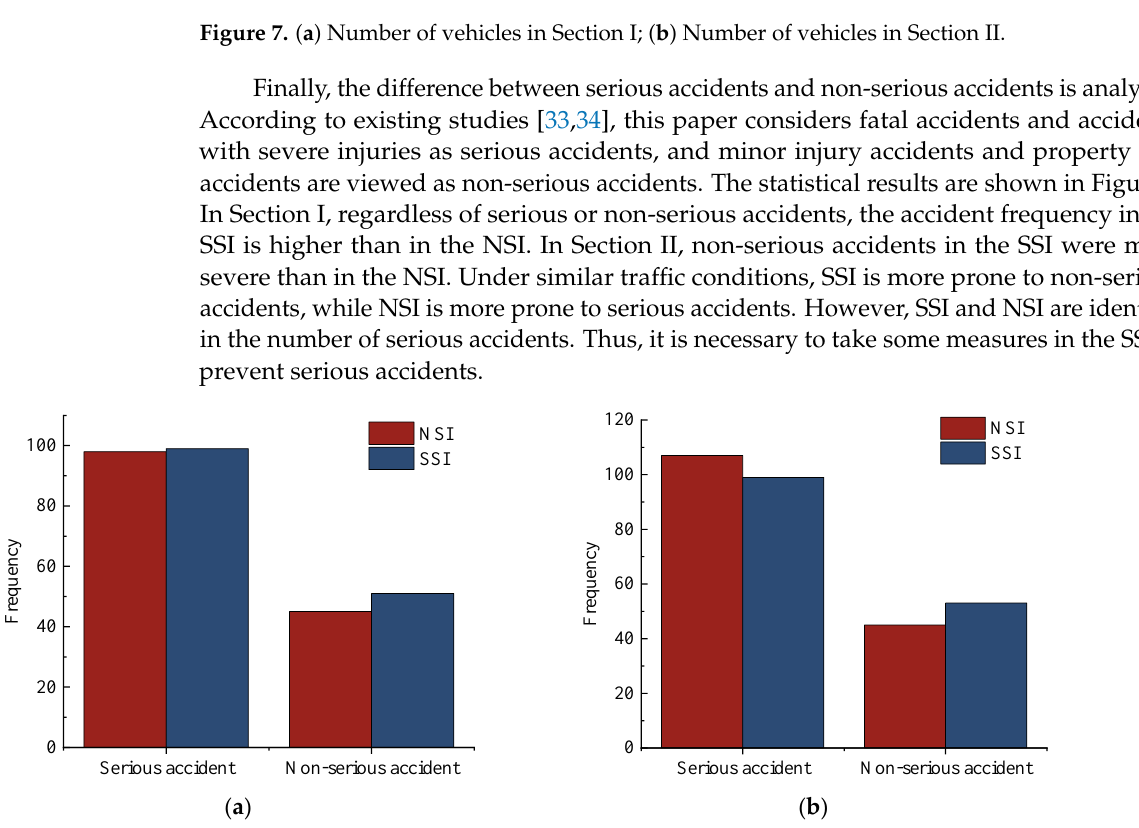
Figure 8. ( a ) Number of accident severity in Section Ⅰ ; ( b ) Number of accident severity in Section Ⅱ . In general, SSI and NSI have some similarities and differences. They all belong to the interchange, so there is a certain similarity in the type of accident. For example, rear-end